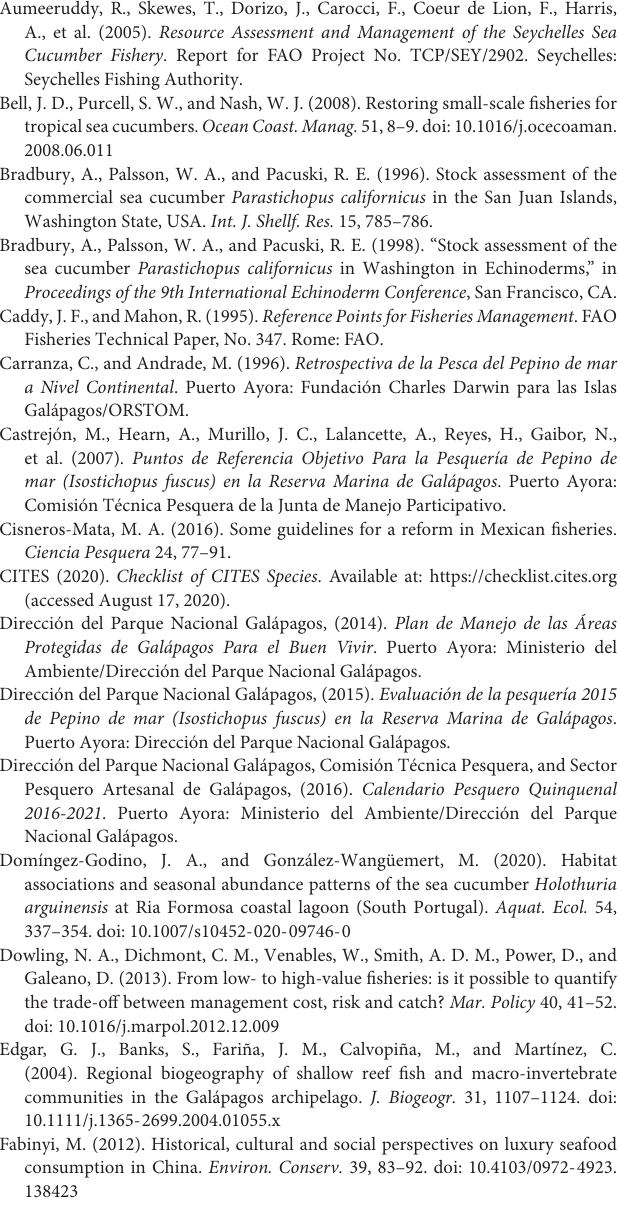
Supplementary Table 4 | General Variance-Inflation Factor results to test the multicollinearity of the variables to standardize the CPUE of I. fuscus . In gray variables eliminated due GVIF > 3. Although the variable year had a high GVIF value, it was not eliminated because it is indispensable for producing the standardized CPUE annual series. Supplementary Data Sheet 1 | Multiple regression validation for I. fuscus CPUE standarization. Supplementary Data Sheet 2 | ASPIC 7 script to fit Schaefer model and compute bootstrapped confidence intervals. Supplementary Data Sheet 3 | ASPICP 5 script to made the time series of F/F MSY and B/B MSY and the 10-year